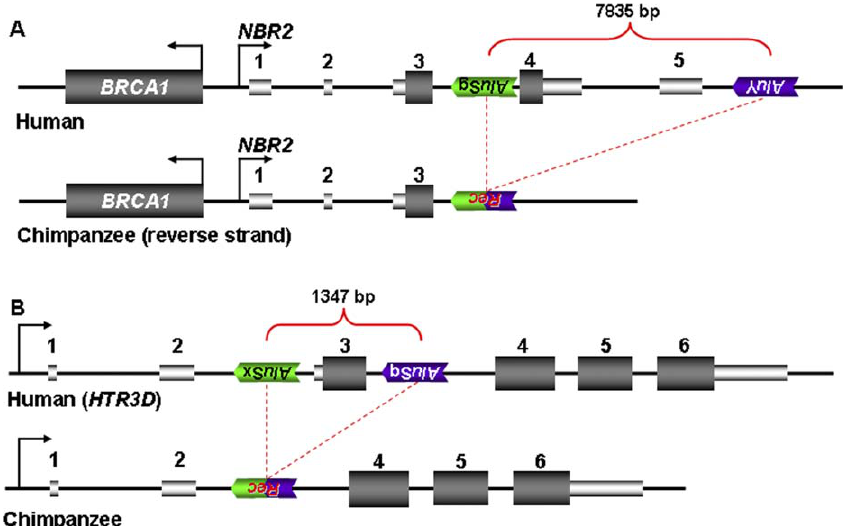
Figure 6. Exonic Deletions Caused by Two ARMD Events Black arrows represent the direction of transcription, and gray and black boxes indicate the noncoding exons and coding exons, respectively. Green and purple arrows indicate elements from two different Alu subfamilies, and dual-color arrows indicate chimeric Alu s generated by ARMD events (map is not drawn to scale). (A) An exonic deletion within the NBR2 gene. The Alu Sg and Alu Y elements are located within the third intron and the 3 9 flanking sequence, respectively, in the human genome. The exon4 sequence is deleted due to an ARMD event in the chimpanzee lineage. (B) An exonic deletion within the HTR3D gene. The Alu Sx and Alu Sq elements are located within the second and third introns, respectively, in the human genome. The exon3 sequence, which includes the initiation codon ATG, is deleted due to an ARMD event in the chimpanzee